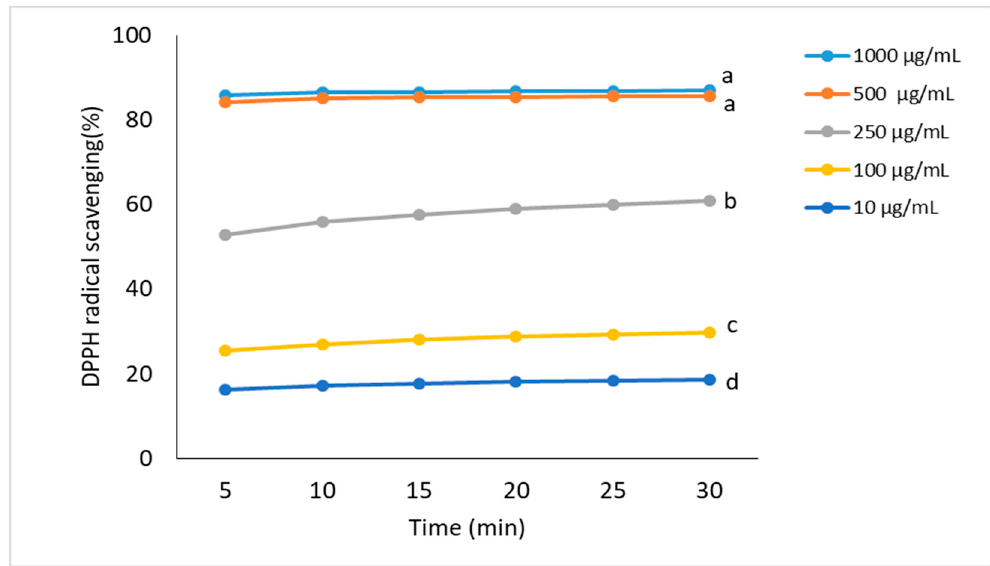
Figure 3. Kinetics of the antioxidant activity changes in the DPPH solutions in the presence of various concentrations of ethanolic extracts from E. angustifolium (FEE). Values are the mean of three replicate determinations ( n = 3). Different letters—values are significantly different, α < 0.05.